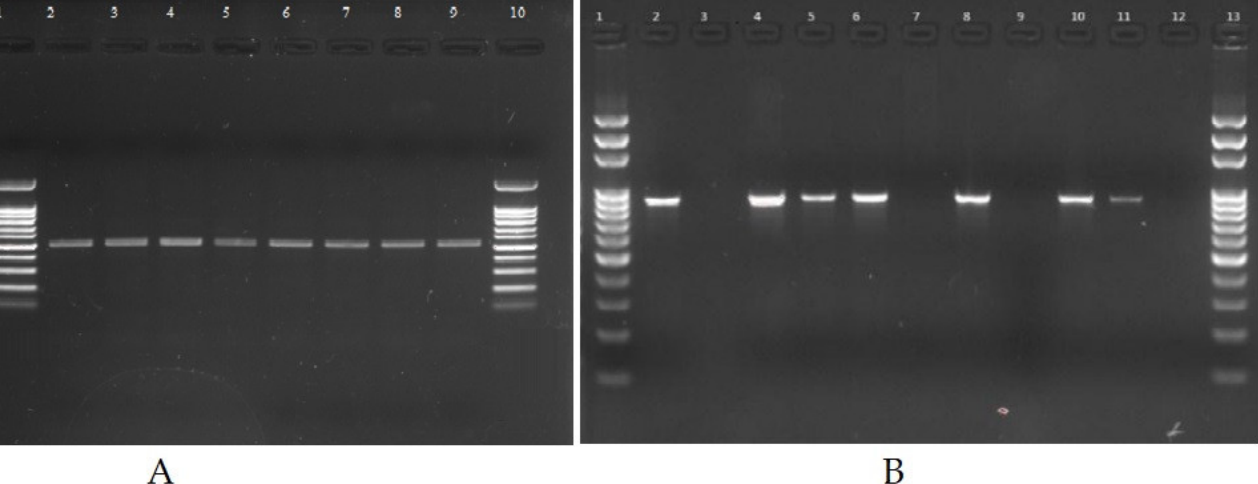
Figure 1. Products of PCR for the detection of USP (884 bp) gene ( A ) and oprL (504 bp) ( B ) on 1.5% EB-stained agarose gel amplified from E. coli and P. aeruginosa , where L1 and 1 are 100 bp DNA ladders.